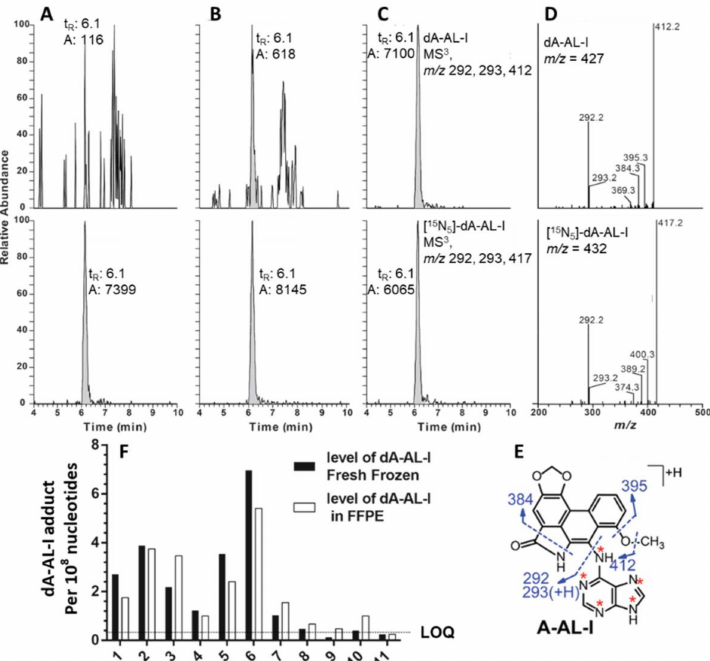
Figure 6. Extracted ion chromatograms of dA-AL-I from human kidney cortex of patients with upper urothelial cancer from Taiwan at levels ( A ) below the LOQ, and positive samples at ( B ) 0.4 adducts, and ( C ) 5.9 adducts per 10 8 bases. The product ion spectra of dA-AL-I obtained from panel C is depicted in ( D ) along with the internal standard [15N5]-dA-AL-I (E, 15N labels of the internal standard of dA-AL-I are depicted with asterisks). Insert ( F ) dA-AL-I adduct levels in matching fresh frozen and FFPE kidney samples, containing both renal cortex and medulla, obtained from 11 individuals residing in endemic regions of Croatia and Serbia who underwent nephroureterectomy for upper urothelial cancer. Reproduced with permission from [104]. Copyright ACS,